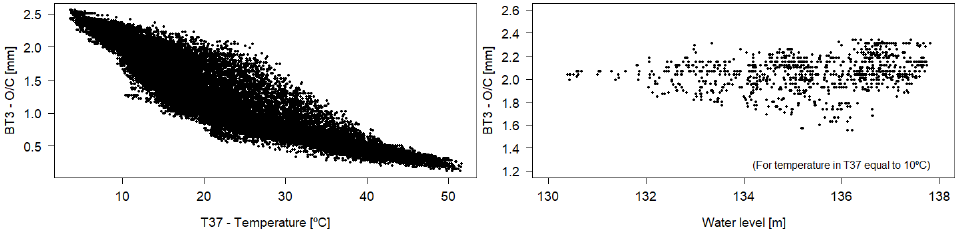
Figure 11. Opening-closing mov. measured in BT3 vs. temperature measured in T37 ( left ). Opening- closing mov. measured in BT3 vs. water level for temperature measured in T37 equal to 10 ◦ C ( right ).